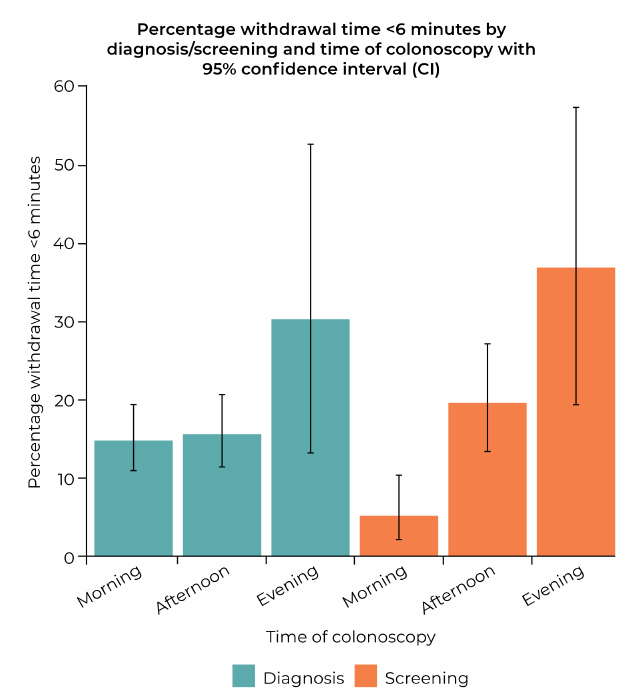
Figure 3. Influence of time colonoscopy was performed on the proportion of procedures with withdrawal time < 6 min according to reason for procedure being diagnosis or screening.